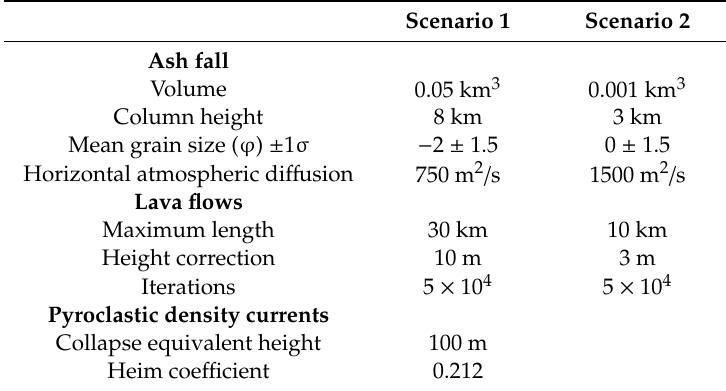
Table 3. Main input parameters used for simulating two eruptive scenarios, i.e., a Sub-Plinian eruption at the central vents and a Strombolian eruption at the NE-SW and NW-SE basaltic rift. The reader is referred to Mart í et al. [10] for the maximum length of lava flows in Scenario 1 and to Scaini et al. [12] for the other parameters as well as the explanation of all the parameters.